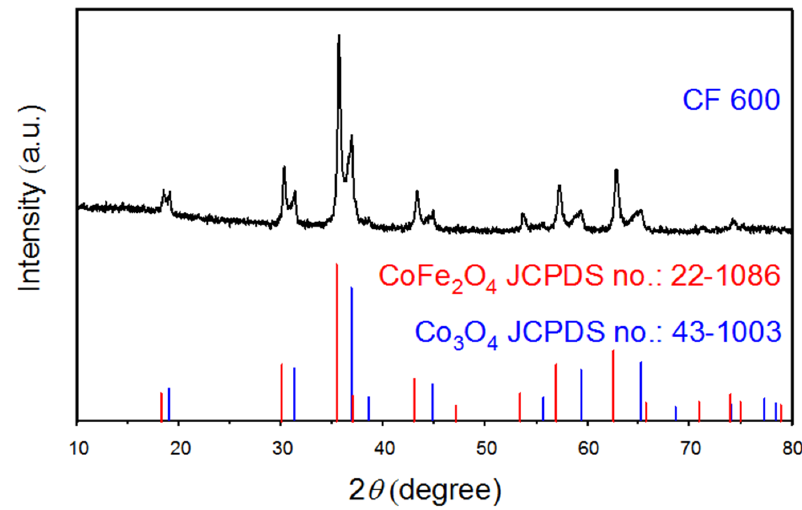
Figure 7. XRD patterns of C 15 H 21 CoO 6 (Co(acac) 2 ) and C 15 H 24 FeO 6 (Fe(acac) 3 ) powder mixture (molar ratio Fe:Co = 2:1) after annealing at 600 °C in air.